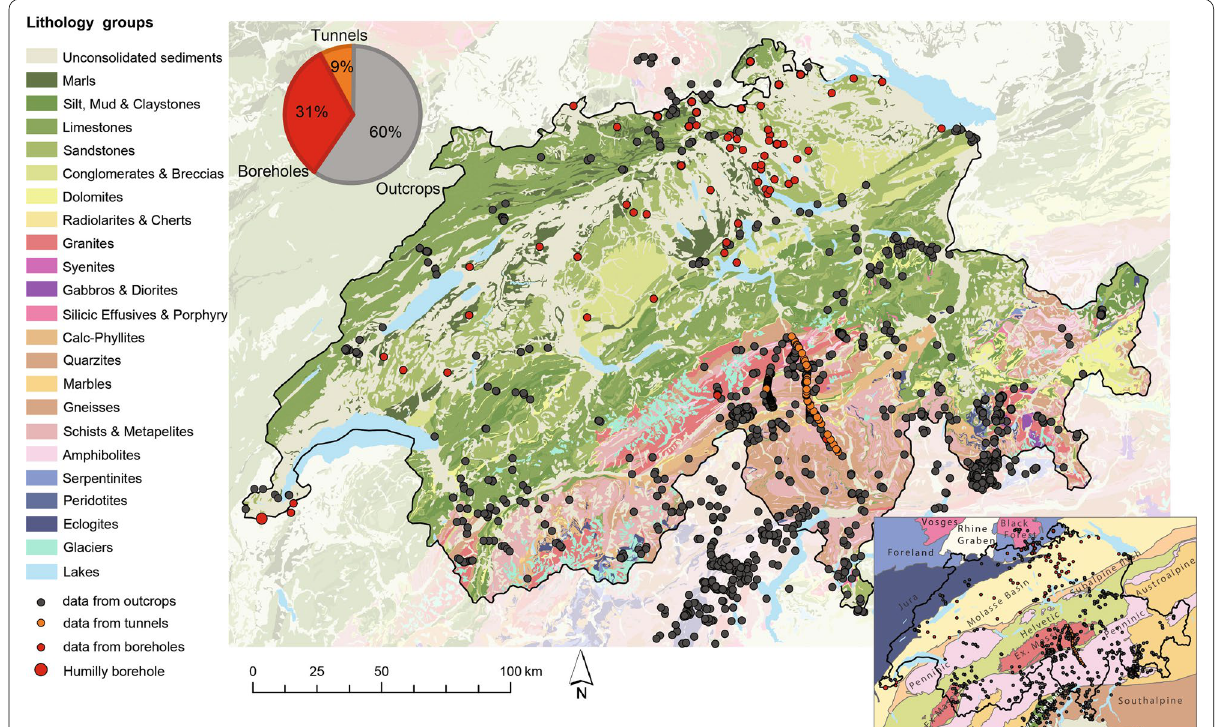
Fig. 1 Simplified lithology map of Switzerland, with data location. Data are subdivided into surface samples (outcrops), samples from tunnels or borehole. The circular diagram shows the relative abundance of the various sources. The numbers in brackets refer to data points as of December 2018 (Modified after Federal Office of Topography 1:500.000 map